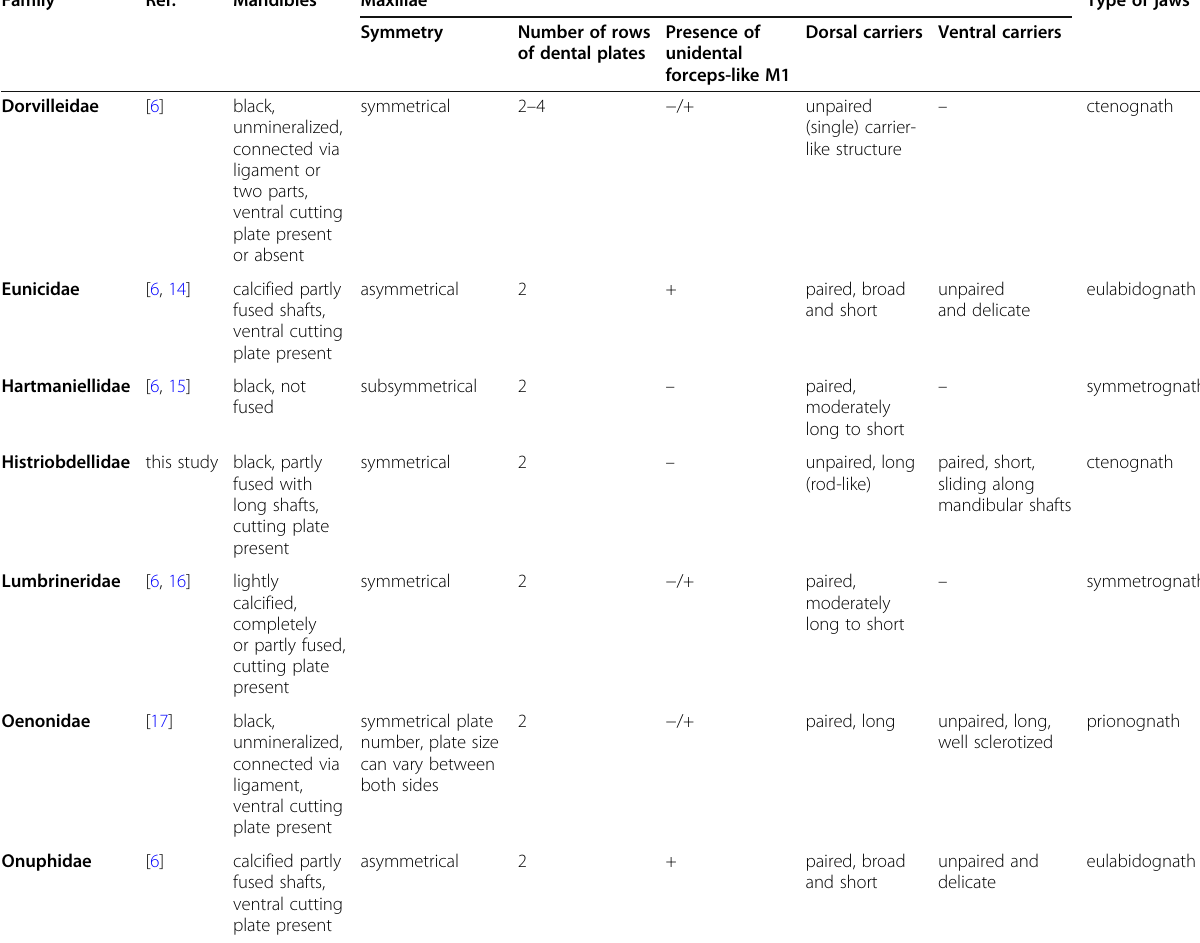
Table 1 Comparison of main jaw features and jaw types in different families within the Eunicida Family